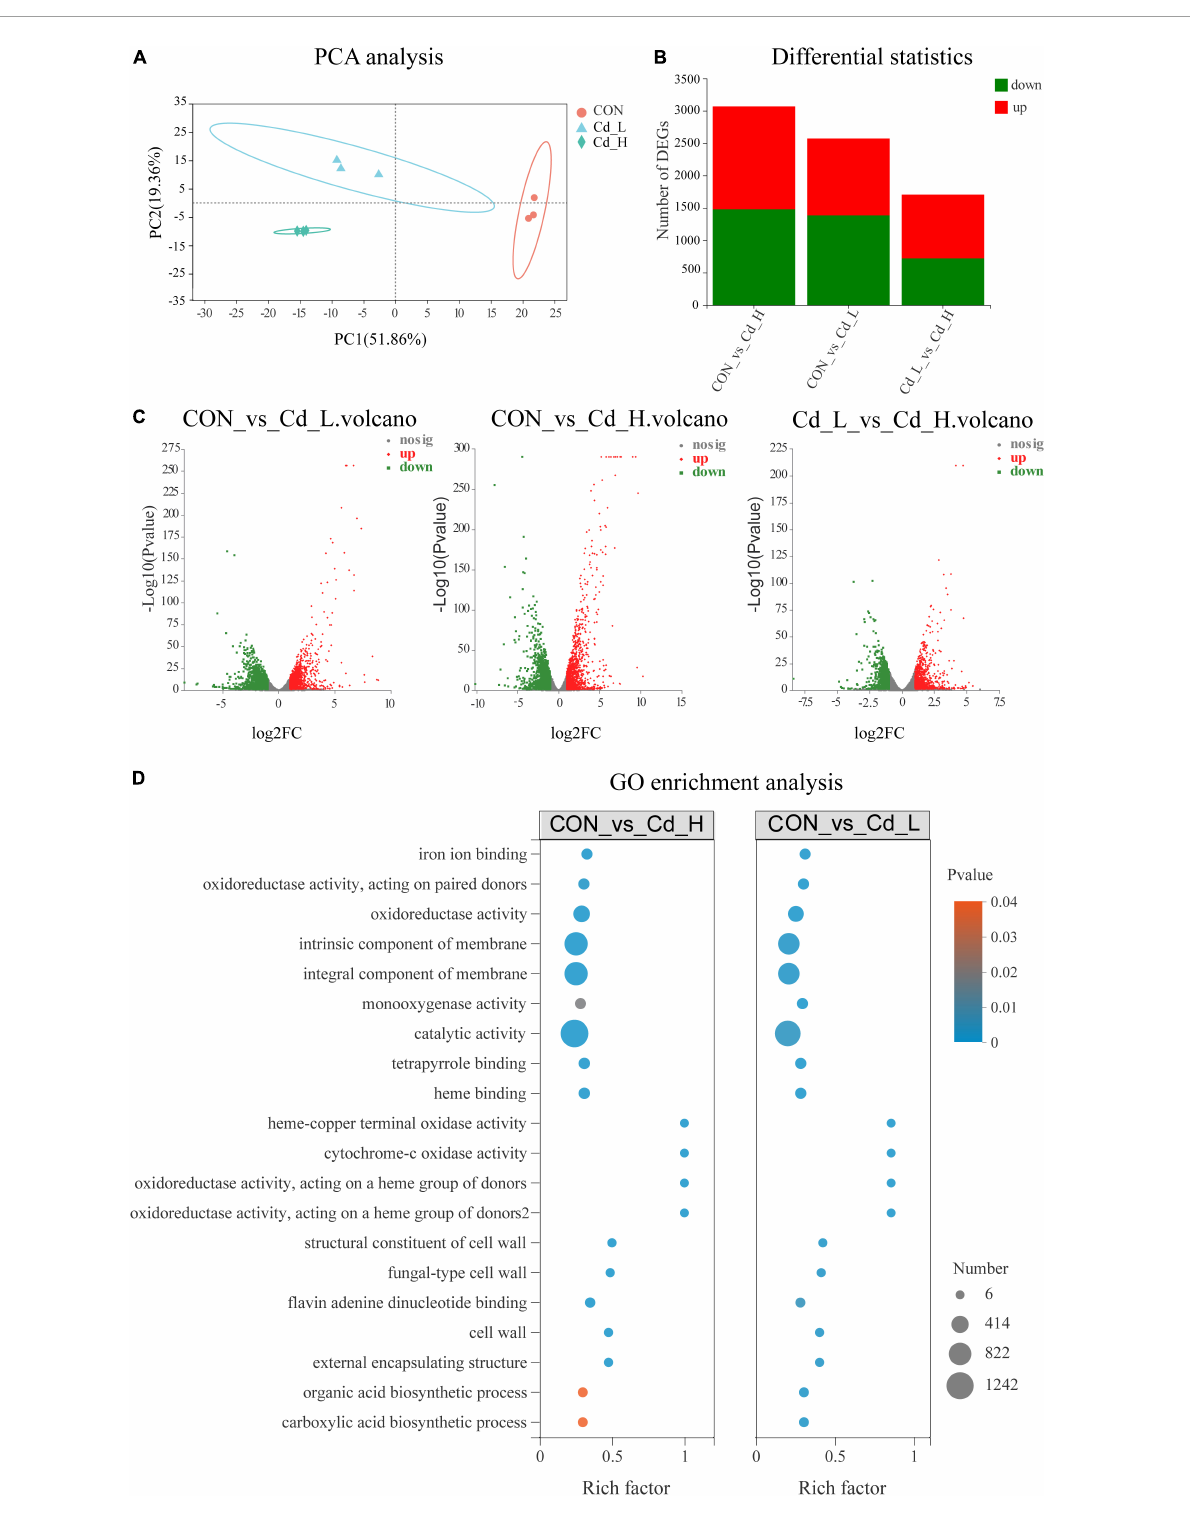
FIGURE3 Effects of Cd stress on T. pubescens by transcriptomic analysis. (A) PCA analysis of the three groups (Cd_L, Cd_H, CON). (B) Statistics of DEGs. (C) Volcano plot (based on the combination of positive and negative ions) between groups. (D) GO enrichment analysis between groups. Cd, cadmium; Cd_L, low-dose Cd treatment group; Cd_H, high-dose Cd treatment group; CON, no Cd treatment group; PCA, principal components analysis; DEGs, differentially expressed genes; GO, Gene